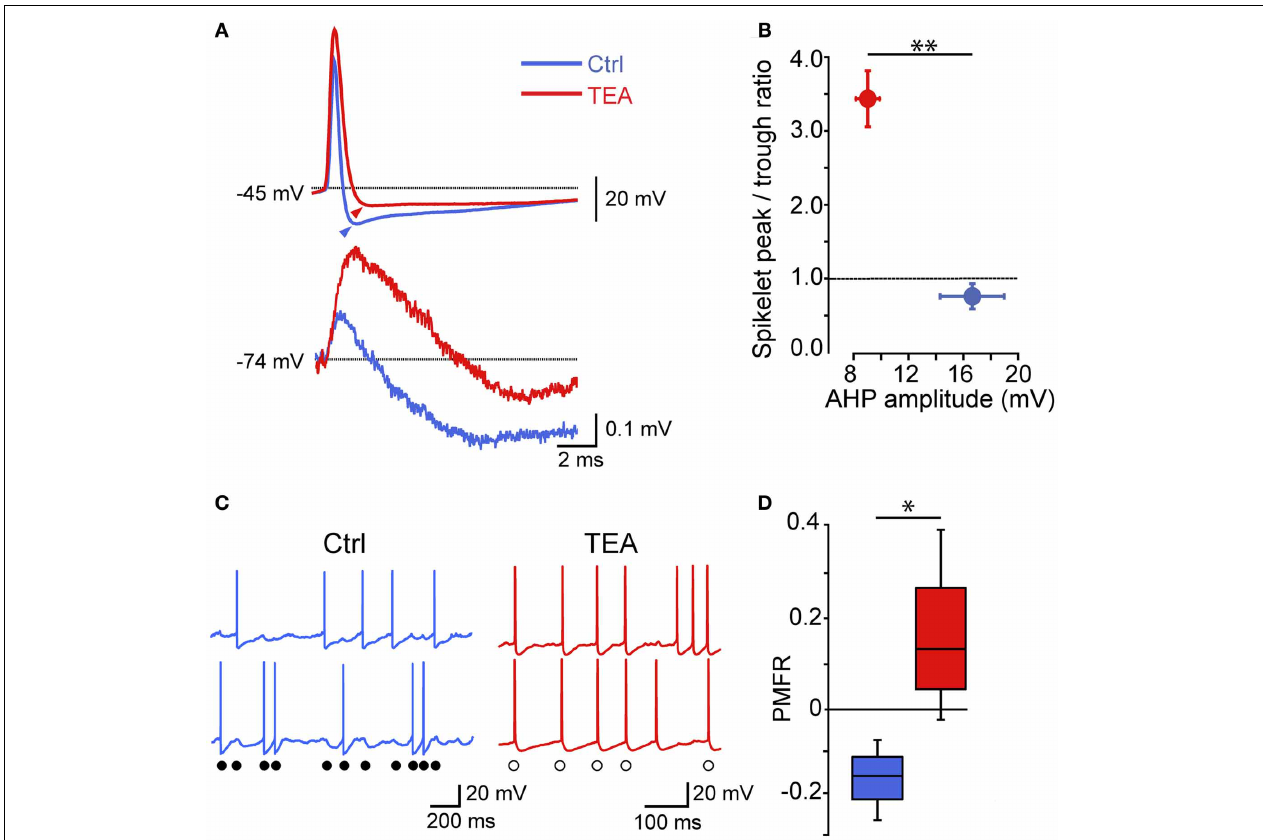
∗∗ p < 0 . 01, paired t -test). (C) Examples of AP trains induced by DC injection (300–400pA) in ctrl (blue) and after bath application of 1mM TEA (red). Filled circles indicate spike inhibition in control conditions while empty circles mark synchronized spikes after TEA application. (D) Summary of PMFR coefficients switching from negative (ctrl) to positive (TEA) values according to the change in ratio between spikelet peak and trough amplitudes ( n = 6, ∗ p < 0 . 05, paired t